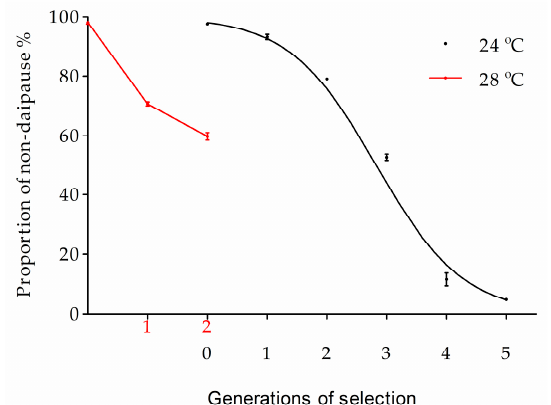
Figure 5. Development of the non-diapausing strain using recurrent selection. Symbols and bars represent the mean ± SE values.